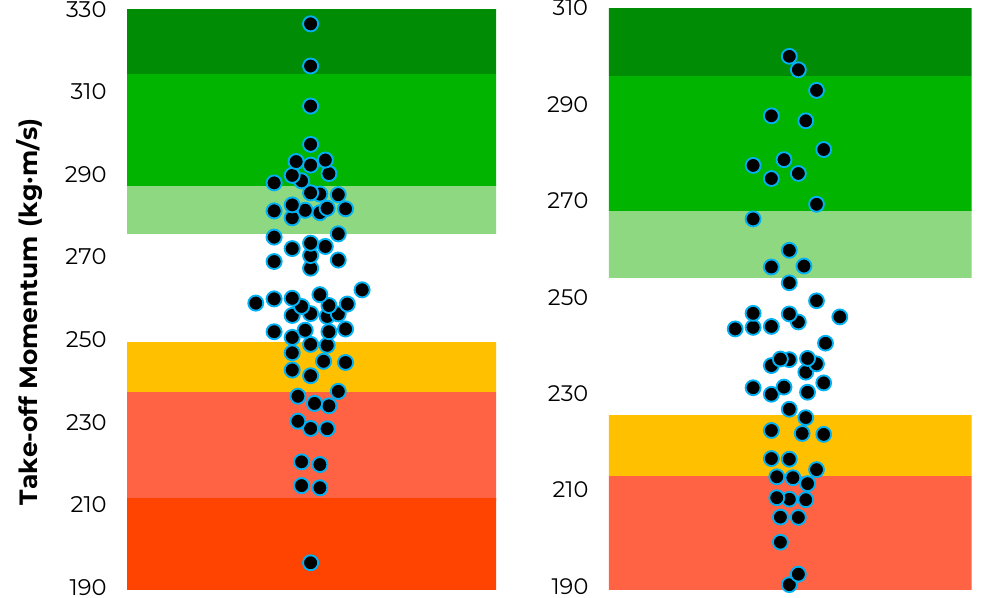
Figure 4. Distribution of jump momentum scores (represented by the individual dots) and corresponding traffic light system based on T-score thresholds for rugby league forwards ( left ) and backs ( right ).